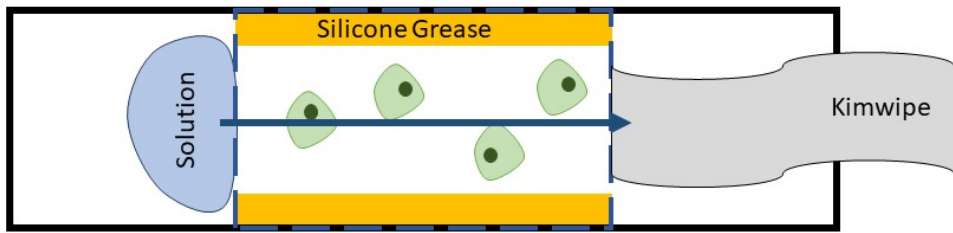
Figure 3. Rudimentary perfusion chamber showing plant cells in green, silicone grease in yellow, wicked solution in blue, and Kimwipe in grey on a white microscope slide (outlined in solid black). 25 × 50 mm cover slip placed on top of grease shown in blue dashed lines.